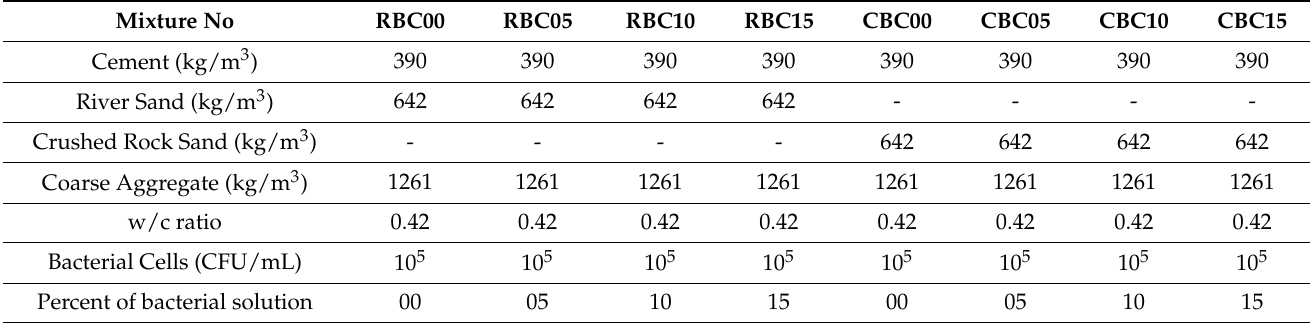
Table 4. Proportion of ingredients per one cubic meter of M40 grade